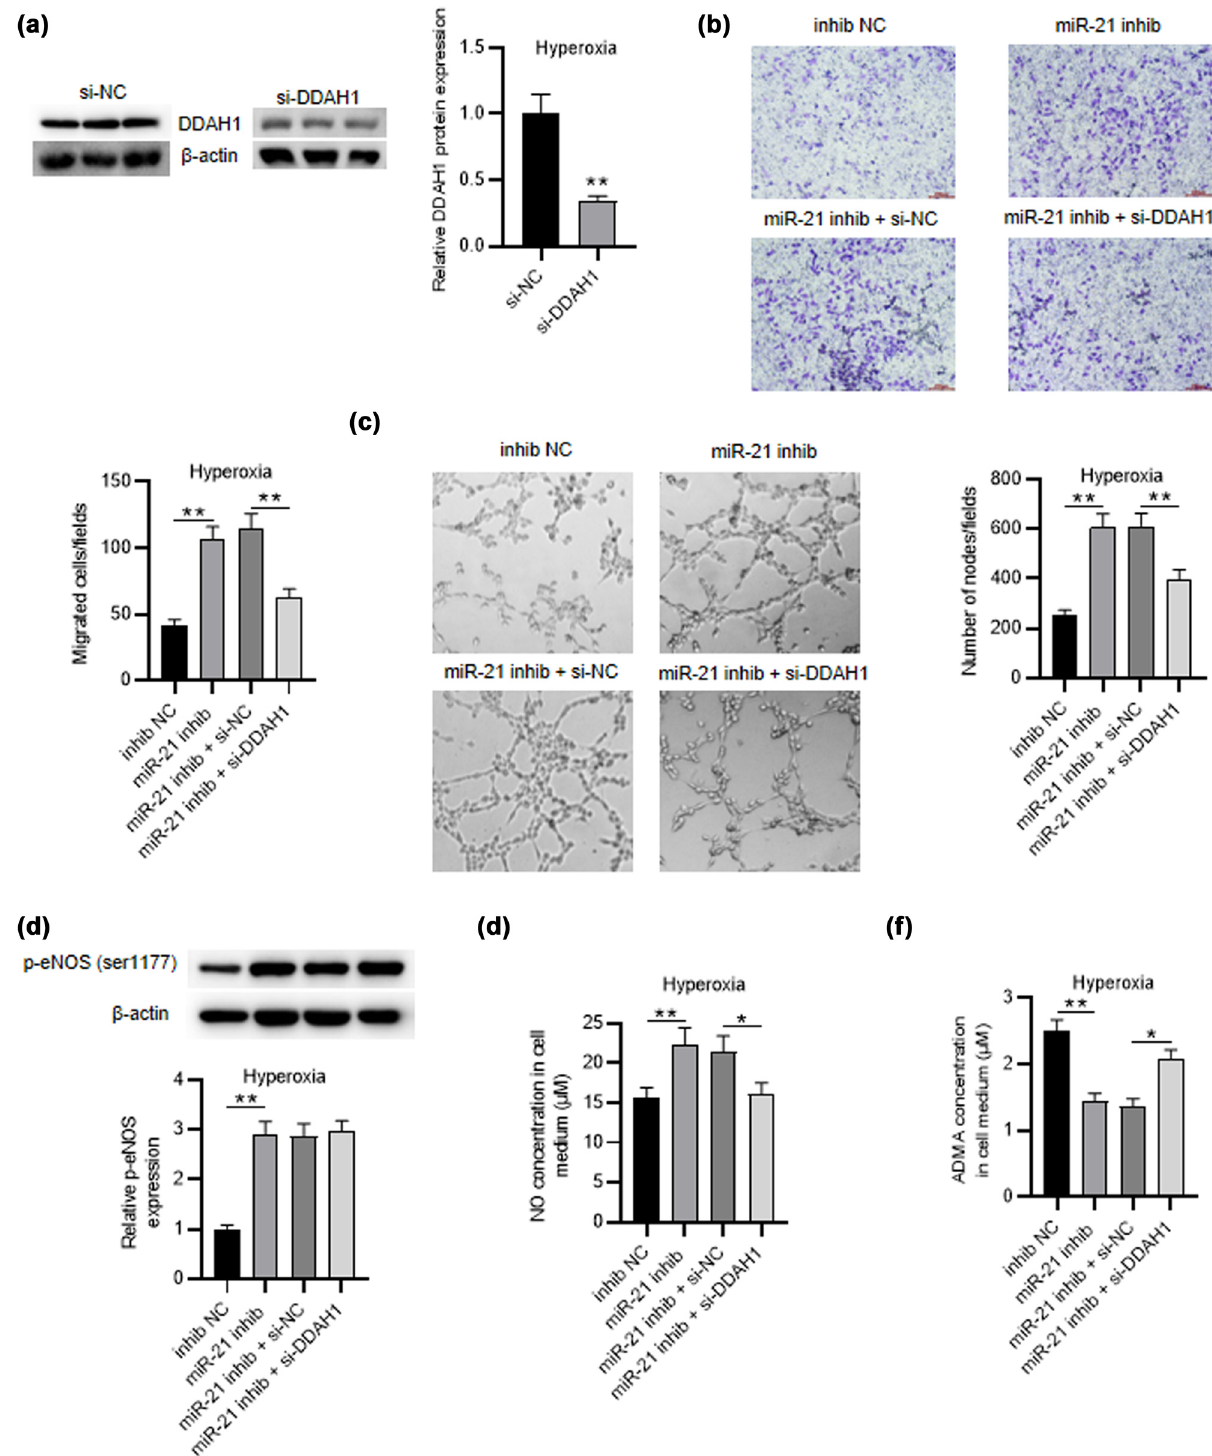
Figure 5: DDAH1 knockdown reverses the e ff ects of miR - 21 depletion on hyperoxia - induced PMVEC behaviors, NO production, and ADMA concentration. ( a ) Western blot was performed to test the knockdown e ffi ciency of si - DDAH1 in hyperoxia - induced PMVECs. ( b ) Transwell assay was applied for measuring the migration of hyperoxia - induced PMVECs in di ff erent groups ( NC inhibitor group, miR - 21 inhibitor group, miR - 21 inhibitor + si - NC group, miR - 21 inhibitor + si - DDAH1 group ) . ( c ) Tube formation assay was performed to estimate the angiogenic activity of hyperoxia - induced PMVECs in di ff erent groups. ( d ) Western blot was utilized to test the p - eNOS ( ser1177 ) level in hyperoxia - induced PMVECs of di ff erent groups. ( e and f ) ELISA was utilized to detect the NO production and the extracellular ADMA concentration in hyperoxia - induced PMVECs of di ff erent groups. Quanti fi ed values are mean values ± standard deviation of at least three independent experiments. * p < 0.05, ** p <